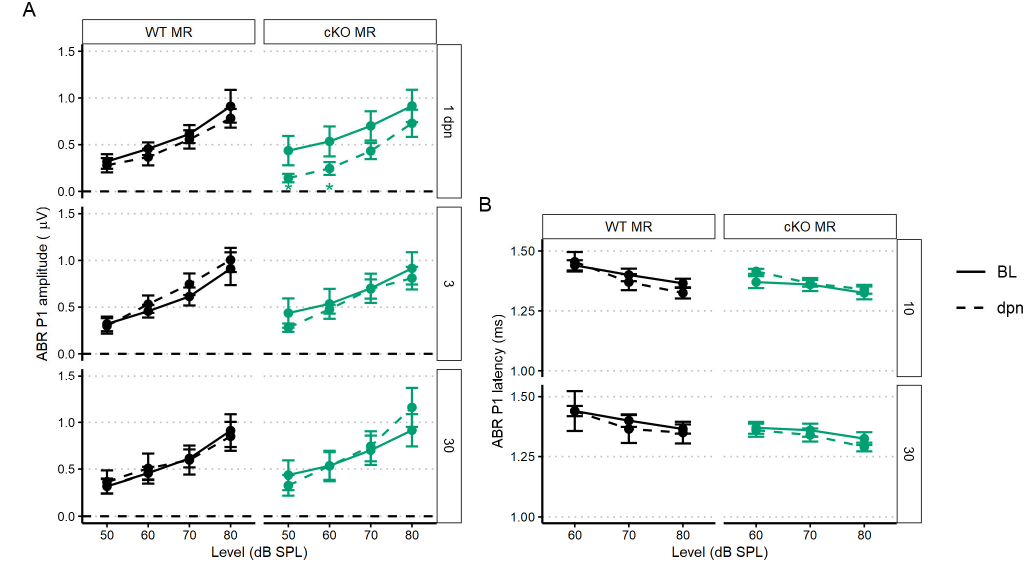
Figure 4. The 22.6 kHz ABR P1 amplitude and latency (mean ± SEM) of cKO MR and control (no tamoxifen) mice following 100 dB SPL mild noise exposure. ( A ) ABR P1 amplitude at 1, 3, and 30 dpn is indicated by a dashed line. Baseline P1 amplitudes are indicated by a solid line (BL). P1 amplitudes were suppressed 1 dpn in the MR cKO mice, but this rapidly recovered to baseline by 3 dpn. No effects of 100 dB SPL noise were observed in control (no tamoxifen) mice. ( B ) ABR P1 latency at 10 and 30 dpn is plotted with baseline P1 latency. No noise-induced changes were evident. Linear mixed effects models were performed in R for statistical analysis.